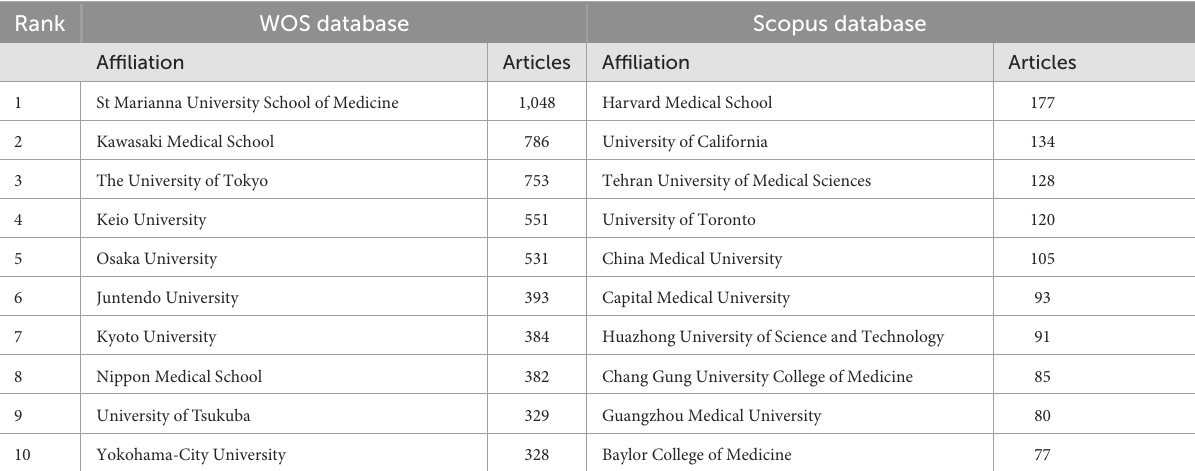
TABLE 3 Ten most productive affiliation in KD research in WOS and